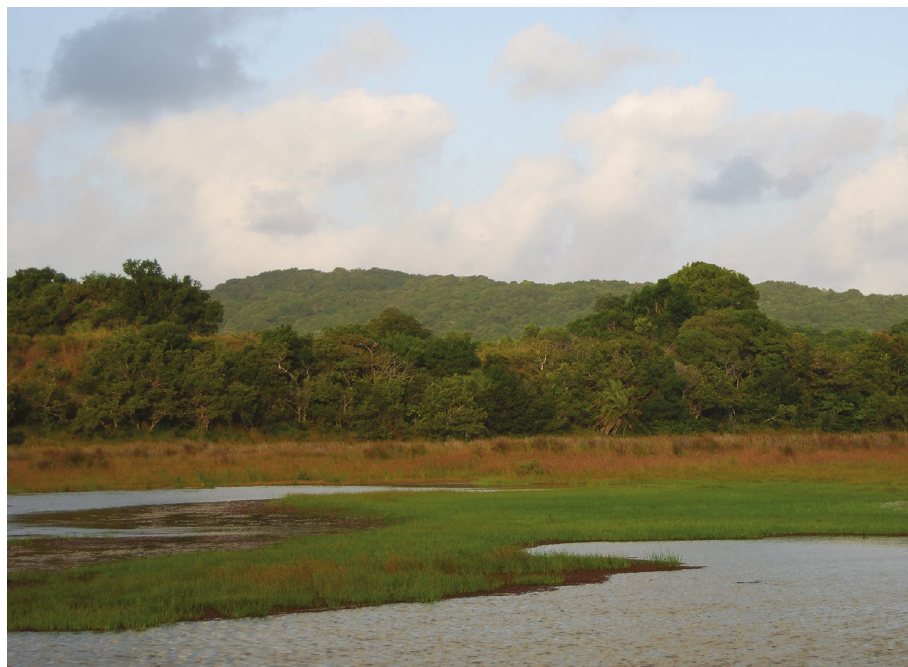
Figure 5. Typical habitat of Lamellothyrea isimangaliso sp. n. in the coastal forest on the Eastern Shores of Lake St Lucia (Photo: Nicola Carrasco, May